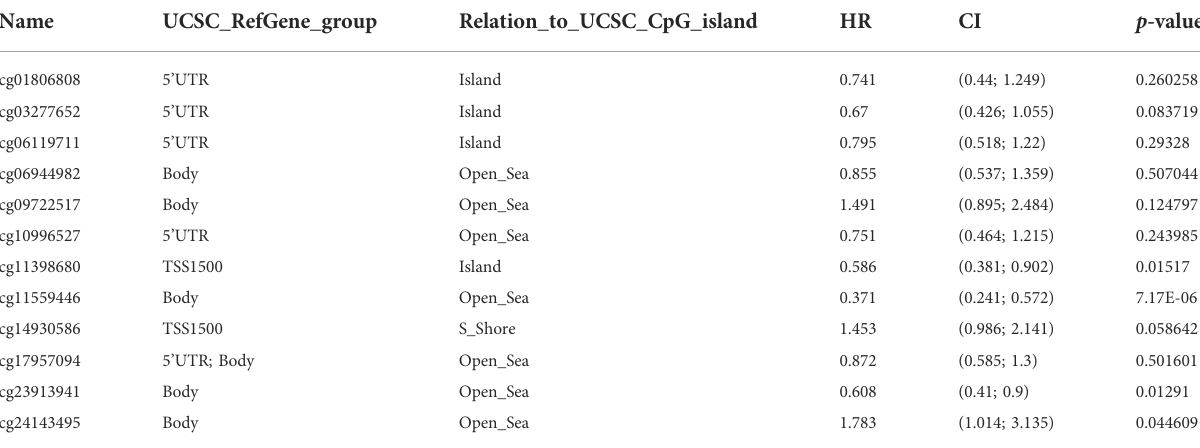
TABLE 2 Signi fi cant prognostic values of CpG in